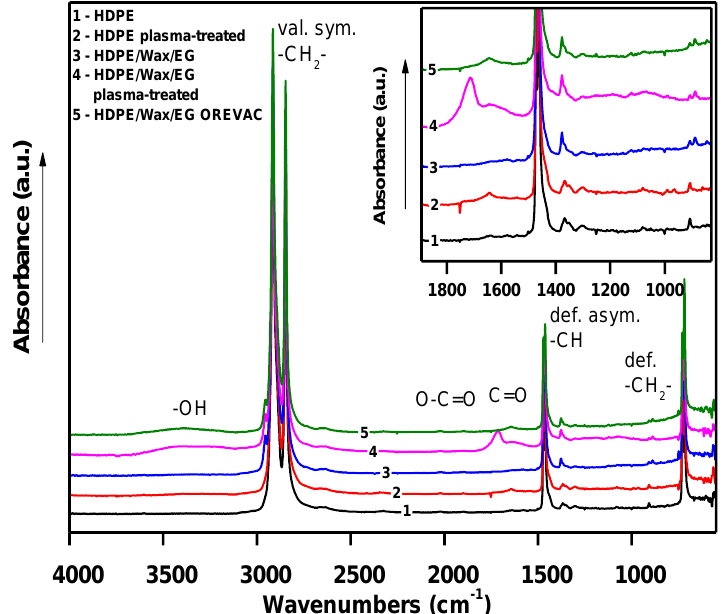
Figure 5. FTIR spectra of SSPCMs samples.